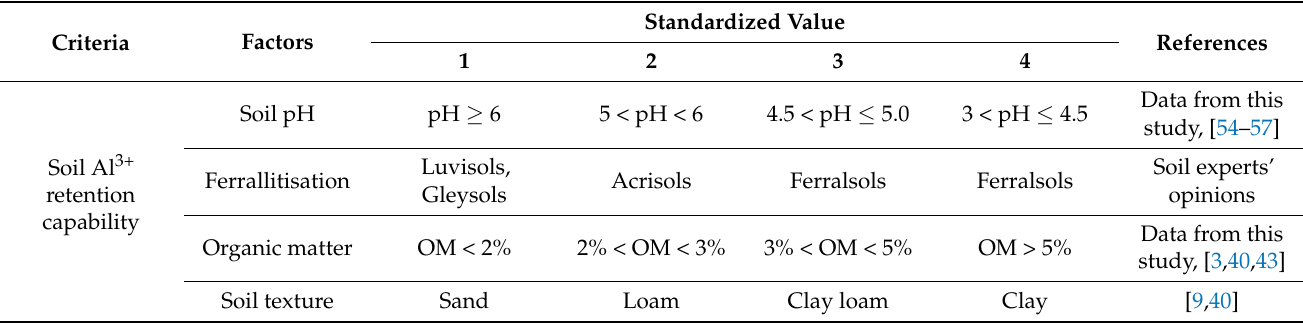
Table 2. Selected influencing factors associated with the significance level for the classification of soil capability in retaining or transporting Al 3+